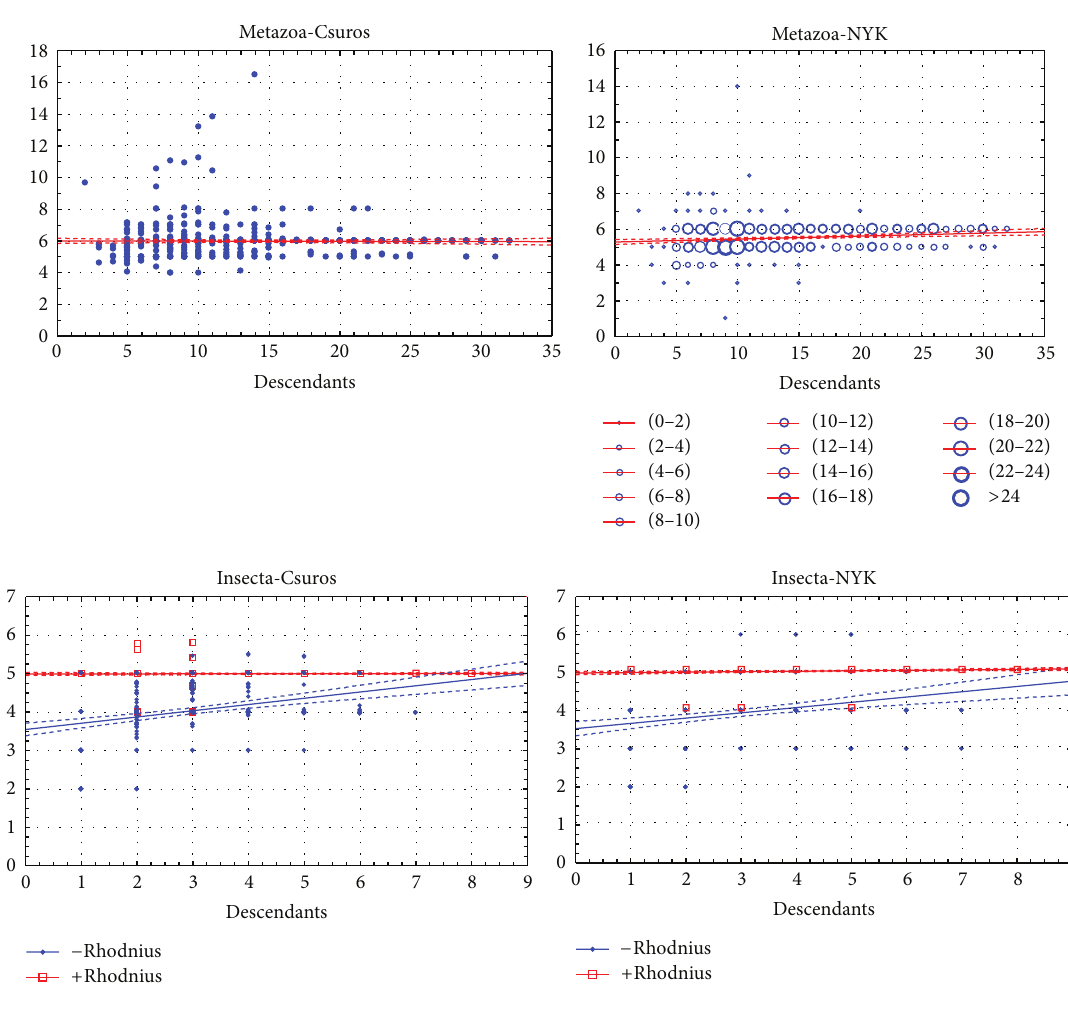
Figure 6: Effects of the number of descendants and sufficiency of taxon sampling. Horizontal axis: number of species in the sampling. Vertical axis: inferred intron density at the node